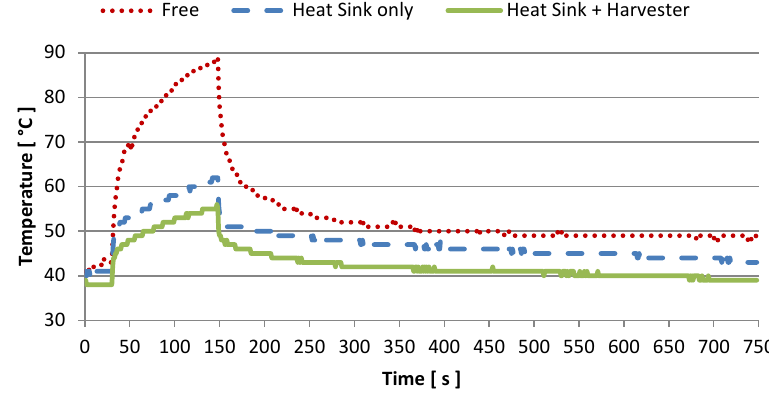
Figure 12. CPU temperature trend in three configuration: with and without the heat sink, and with the proposed prototype on